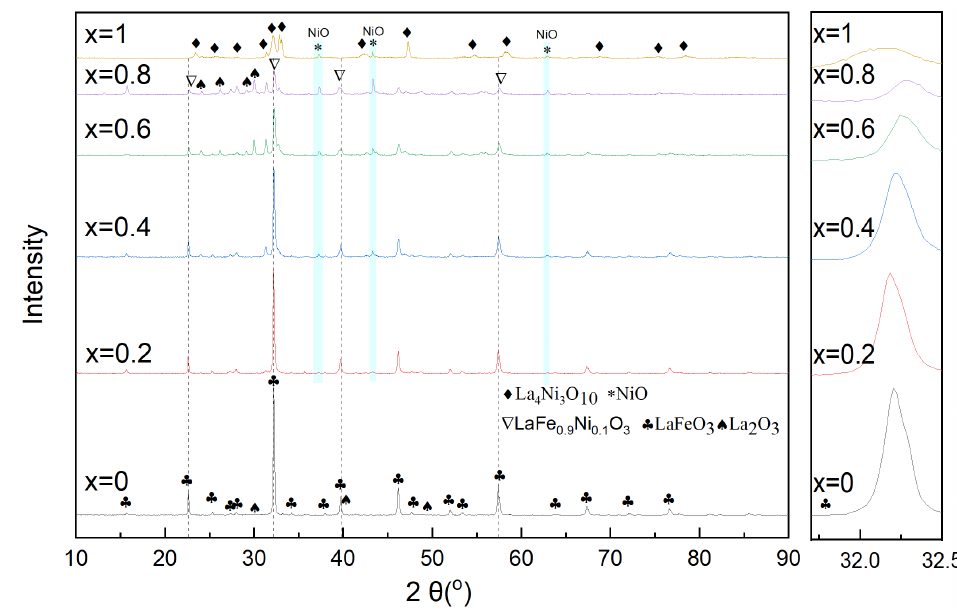
Figure 8. Phase patterns of LaFe 1-x Ni x oxygen carriers.